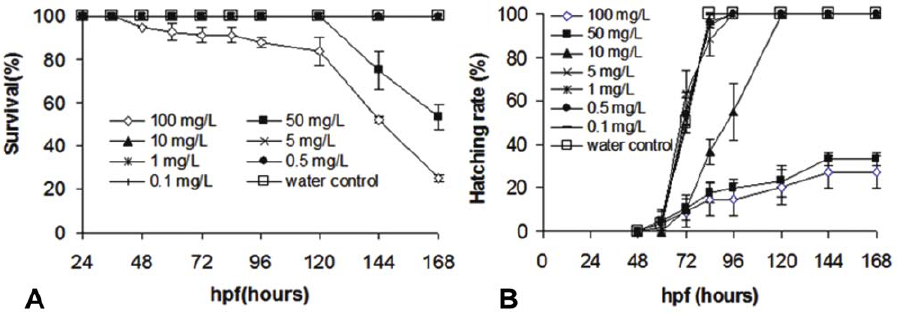
Figure 2. Survival (A) and Hatching rate (B) of zebrafish embryos exposed to different concentration of nFe 2 O 3 over 168 h. Error bars represent 6 one standard deviation from the mean of three replicates.